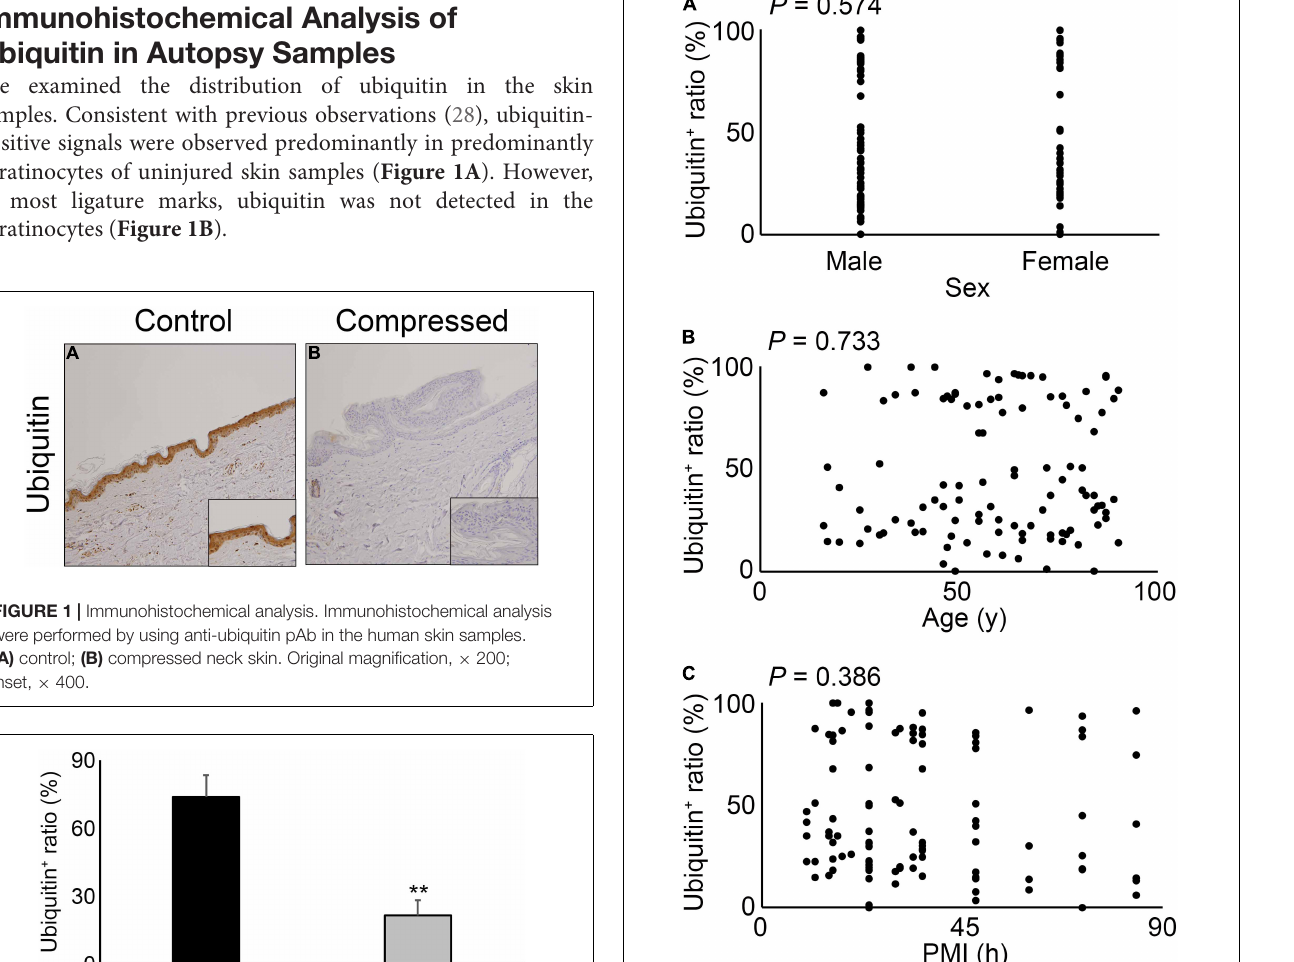
FIGURE 2 | The ratio of ubiquitin positives in the corresponding keratinocytes in the skin sample. ** P < 0.01.